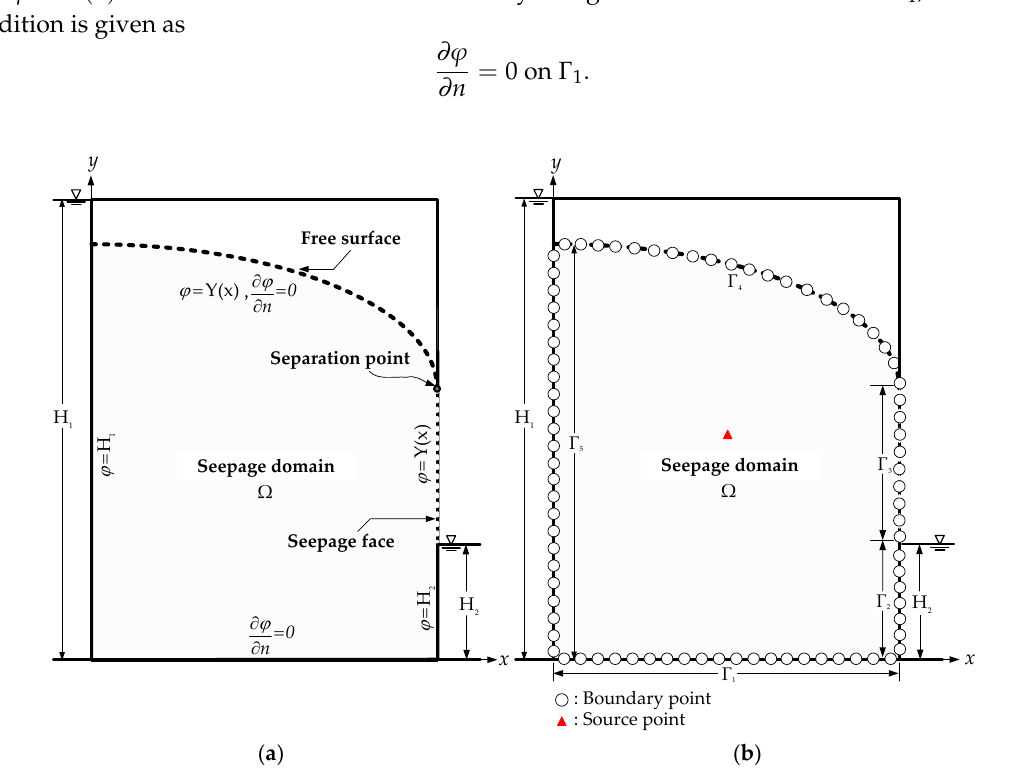
Figure 1. Nonlinear moving surface through a rectangular dam. ( a ) The cross section and boundary conditions and ( b ) collocation points on the boundary.